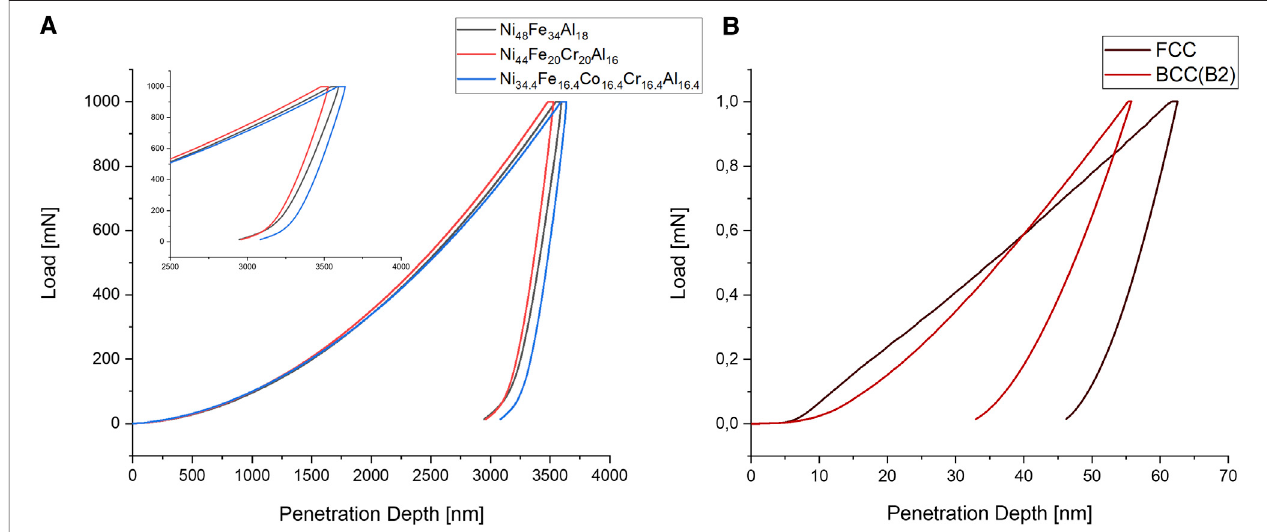
FIGURE 7 | Mean load-depth pro fi les of the three alloys from micro-indentation experiments (A) and mean load-depth pro fi les of nano-indentation probing of the individual phases of the Ni 44 Fe 20 Cr 20 Al 16 alloy (B) .